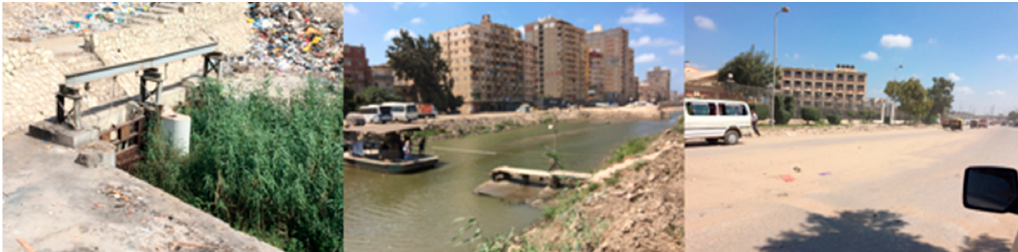
Figure 3. The Mahmoudia Canal in Egypt. Source: Author. Legend: The downstream end of the canal, located nearby a police station, is surrounded by garbage heaps ( left ); the bank earth of the canal is mixed with garbage, located in front of the water plant of Alexandria ( middle ); the water plant viewed from the canal ( right ). Location: 31°11 ʹ 05.6 ʺ N 29°52 ʹ 55.4 ʺ E ( left ), 31°13 ʹ 14.6 ʺ N 29°59 ʹ 27.4 ʺ E ( middle and right ).